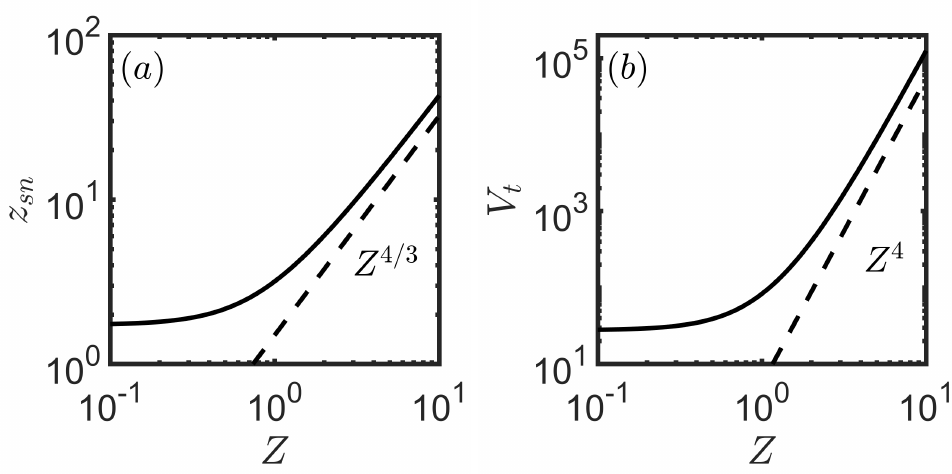
Figure 8. Logarithmic plots showing the variation of the ( a ) saddle-node bifurcation point z sn and ( b ) trapped volume V T with Z (solid line). Both plots conform to the expected scaling (dashed